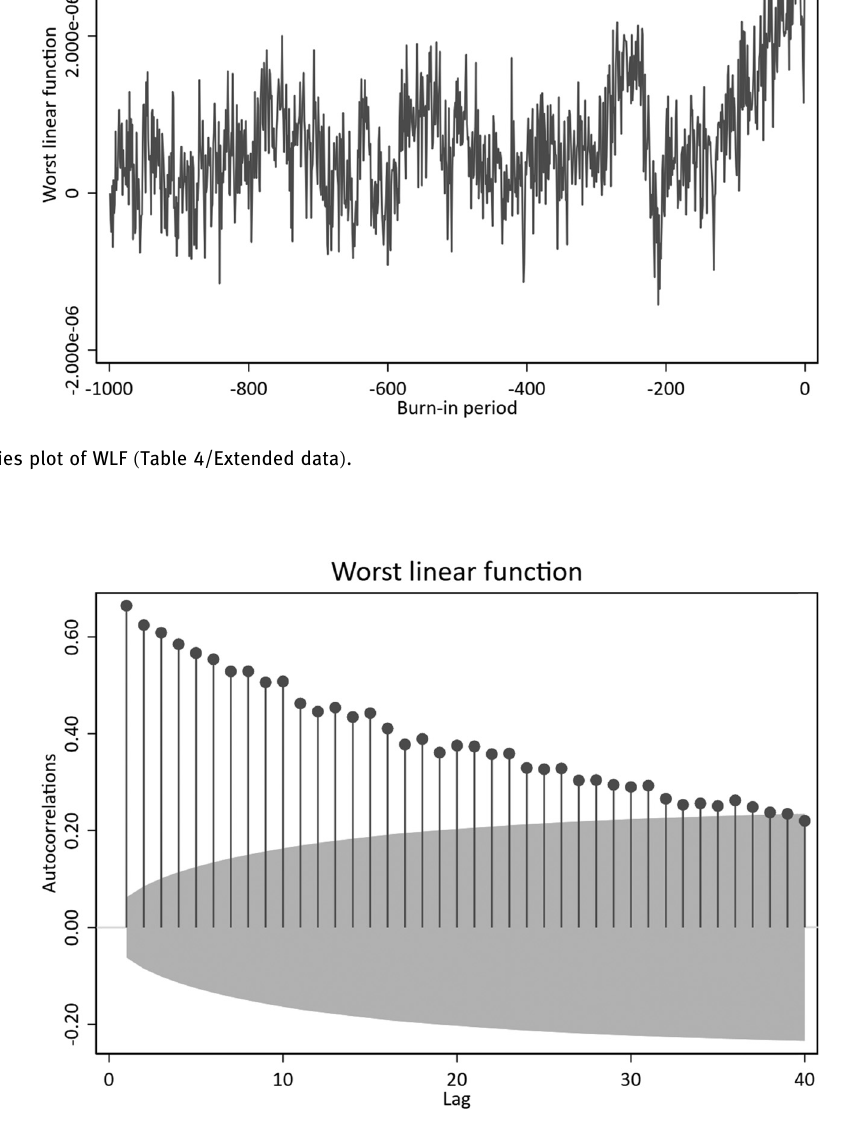
Figure A4: Autocorrelation plot of WLF ( Table 4/extended data )